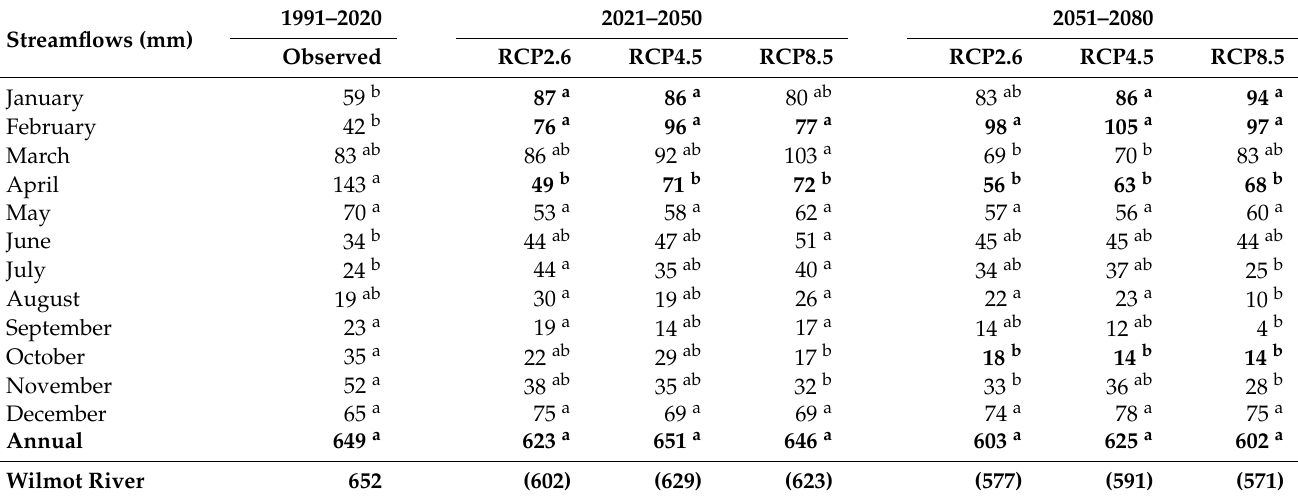
Table 14. Average streamflows (mm) observed in the western zone (at Carruthers Brook, and Wilmot Valley of Mill, and Wilmot River watersheds respectively) during the 2000s, and modeled future projections during the 2030s and